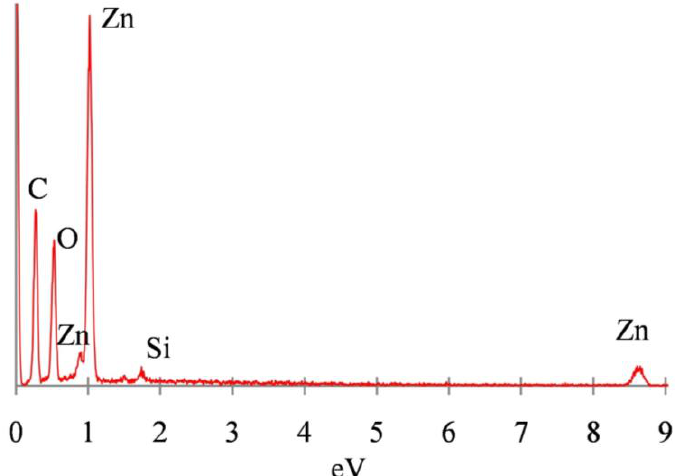
Figure 3. Energy Dispersive X-Ray Spectroscopy (EDS) spectrum for ZnO microstructures generated at 20 min of reaction time showing presence of